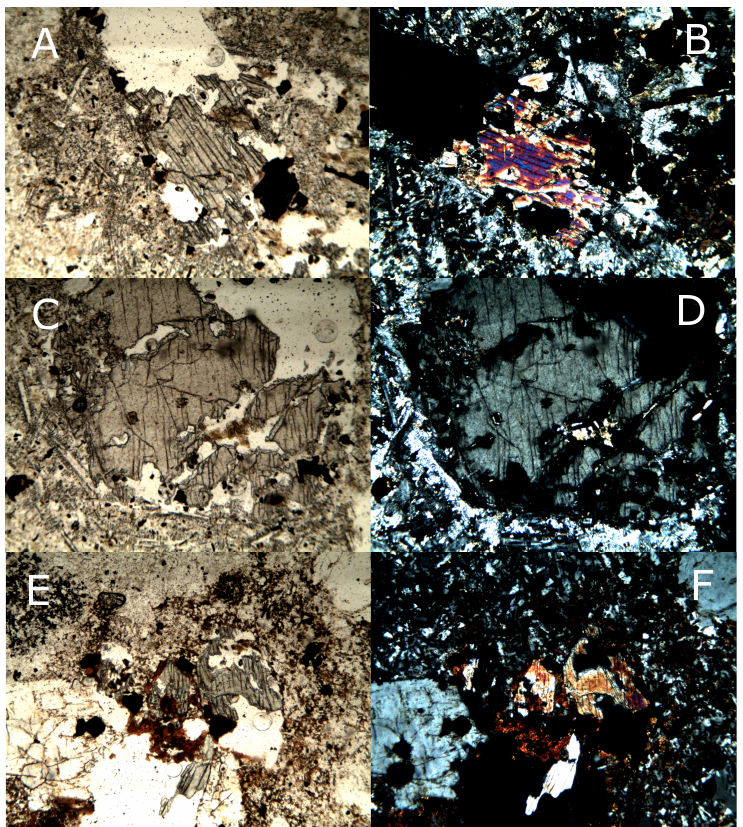
Figure 4. Selected microphotograph (4.5 × magnification) of clinopyroxene from host ( A , C ), and enclaves ( E ) samples. ( A , C , E ) parallel polarised light; ( B , D , F ) corresponding cross-polarised